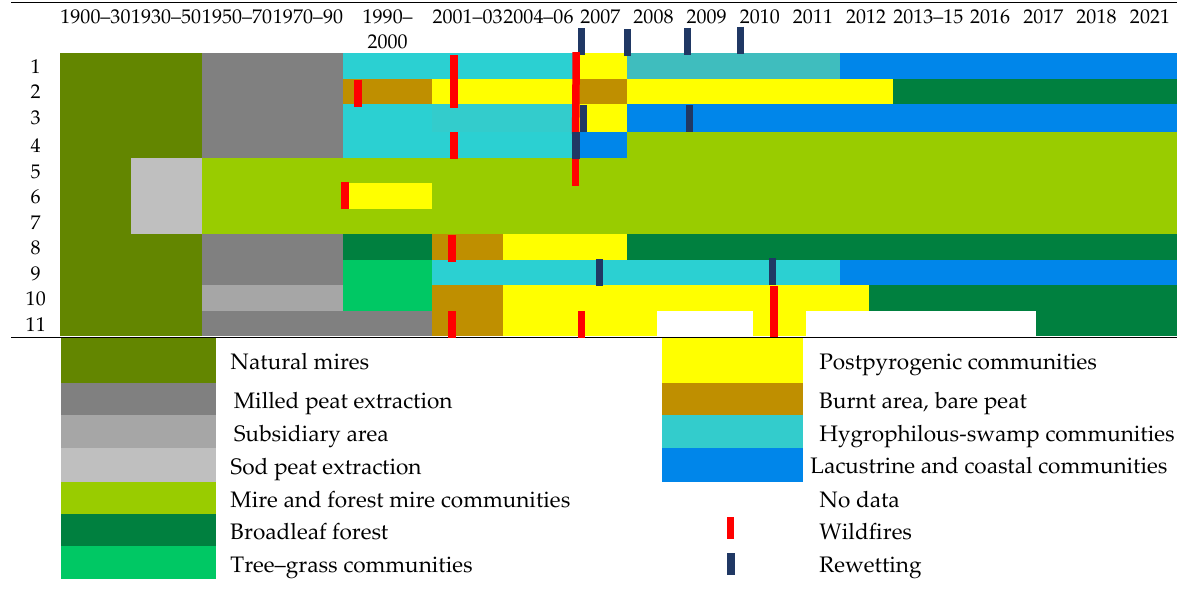
Figure 20. Combined scheme of vegetation change at monitoring plots after peat extraction, fires and rewetting.